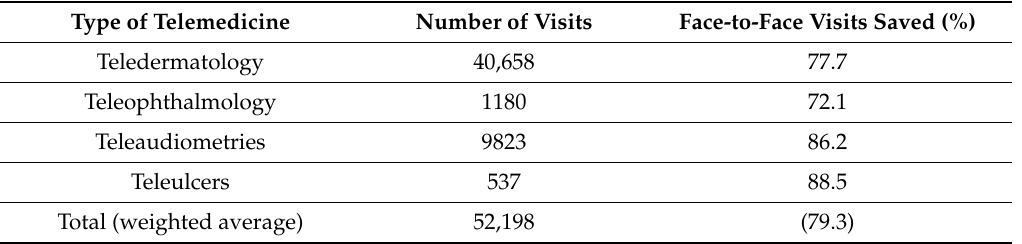
Table 1. Number of telemedicine visits and% of face-to-face visits saved, per